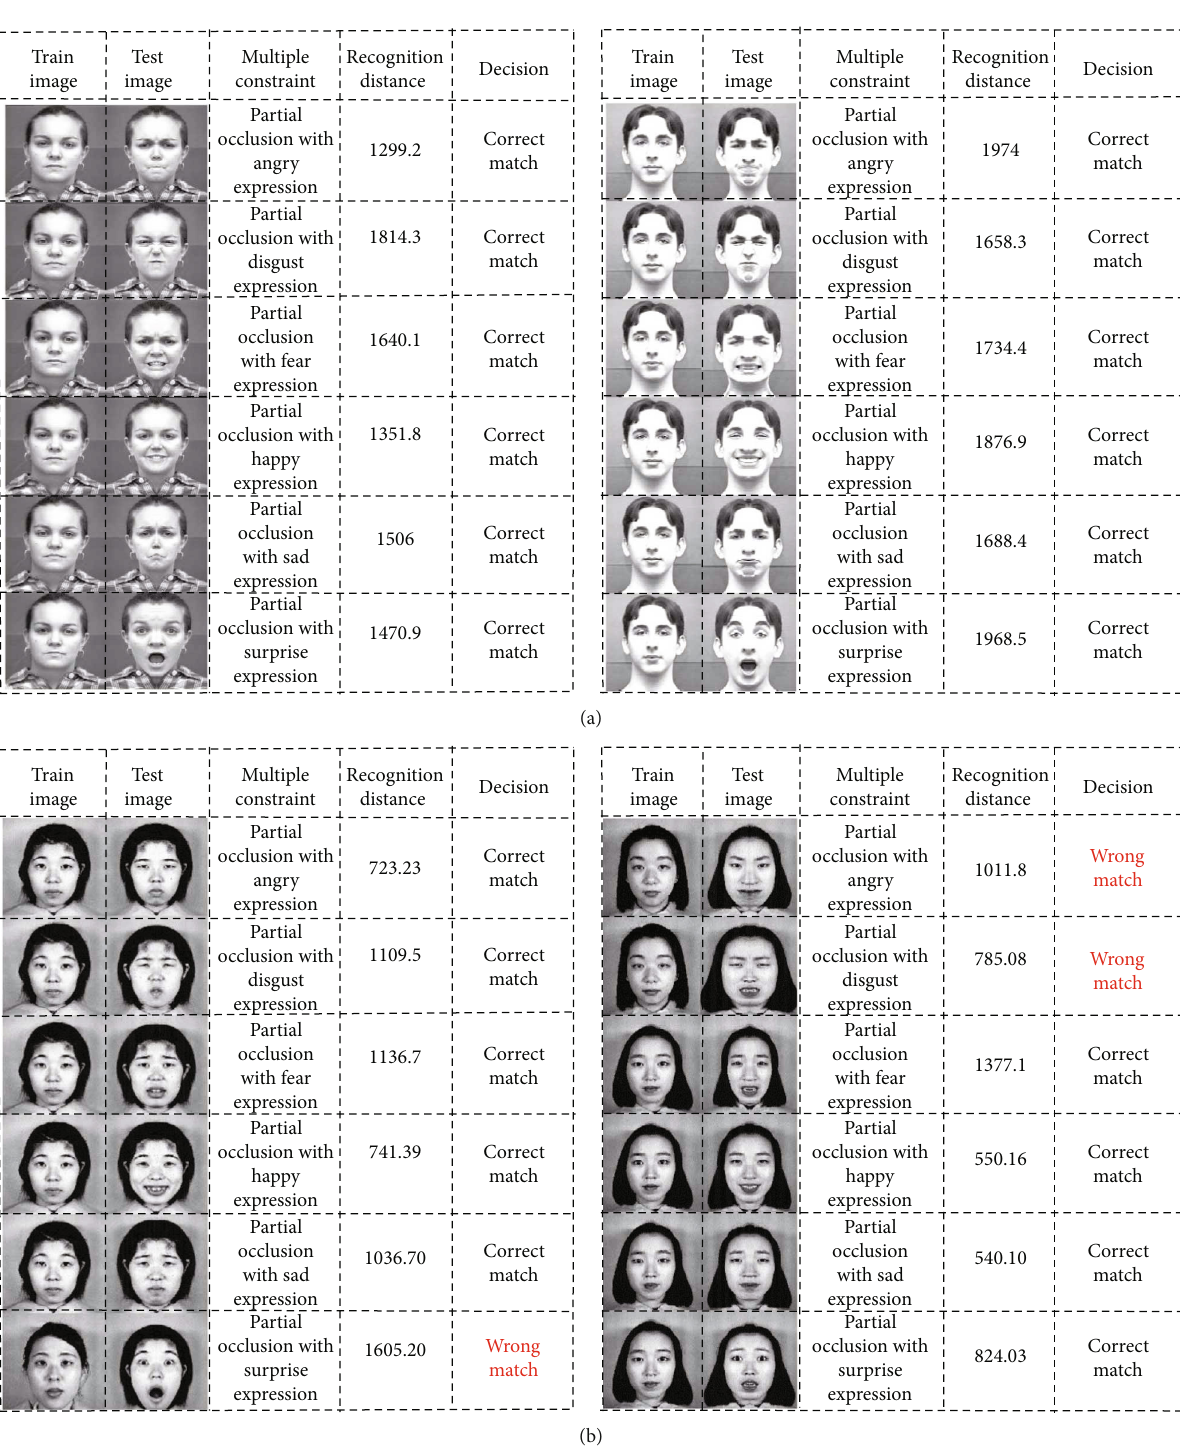
Figure 8: Recognition results of some right reconstructed face images with varying expressions: (a) sample recognition results from the CKFE database; (b) sample recognition results from the JAFFE